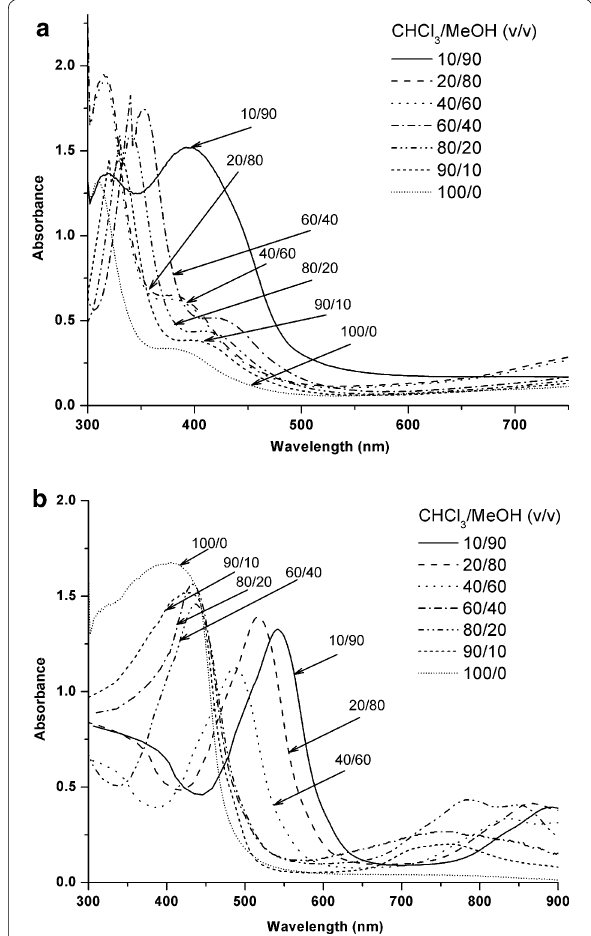
Fig. 9 UV–vis spectra of PBDP3HTTPA ( a ) and PBDP3HTTPB ( b ) meas‑ ured in CHCl 3 /MeOH